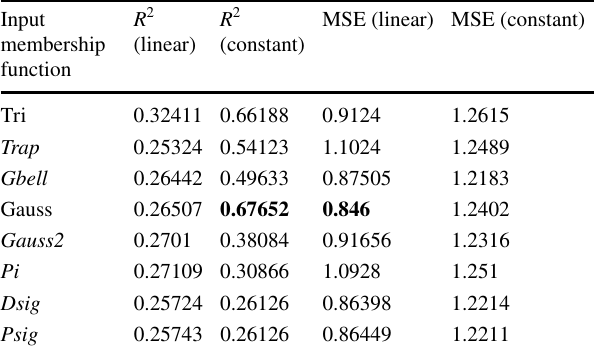
Table 11 ANFIS model efficiency for iron(II) removal using LAC